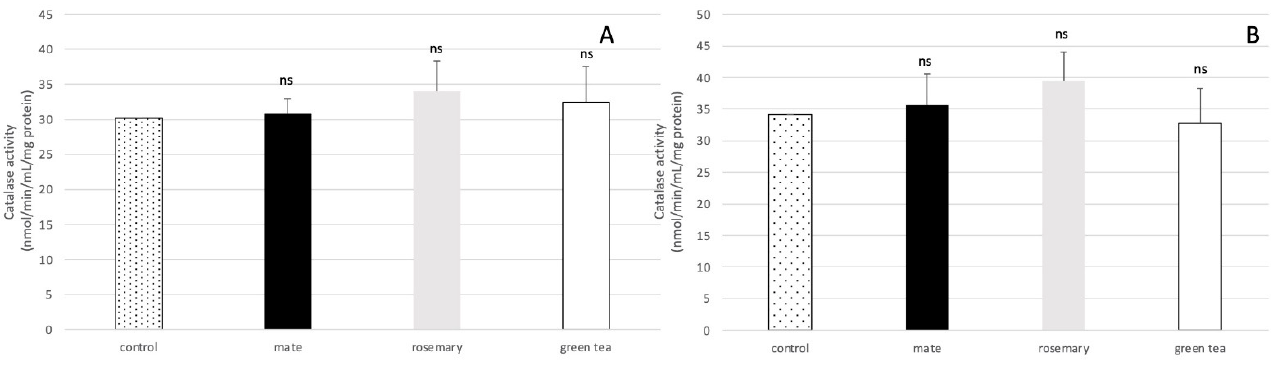
Figure 7. Impact of plant extracts on the catalase activity in A. flavus . ( A ) The fungal strain was exposed to 0.225 mg DM/mL of culture medium of extracts of mate (black bars), rosemary (grey bars), and green tea (white bars) or ( B ) to the IC80 of the three extracts that corresponded to concentrations of 0.16, 1.11, and 0.28 mg DM/mL of culture medium for mate, rosemary and green tea, respectively. Control (bars with black dots) corresponds to catalase activity in A. flavus culture with no extract. Results are given as the mean +/ − SD of 6 replicates. ns: not significant.